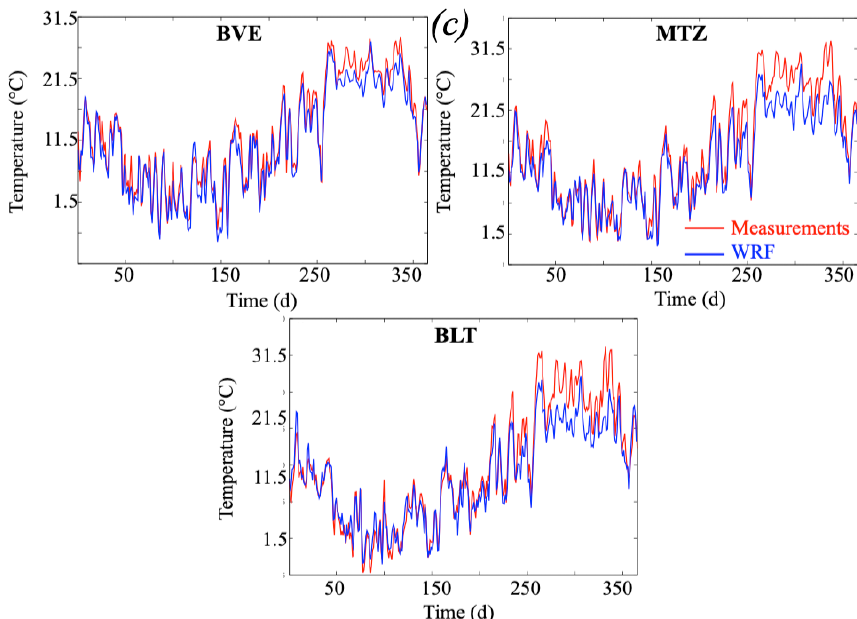
Figure A4. (a) Location of the four selected stations. These stations allow for comparing the simulated precipitation and temperature with measurements in the Sierra Nevada Mountains (BVE and MTZ), the volcanic intrusion (BLT), and the Central Valley (ELG). (b) Comparisons between simulated and measured precipitation at the four selected stations. The reasonable match between measurements and simulations at different locations allows for gaining confidence in the WRF simulations to reproduce the atmospheric dynamics at different elevations. (c) Comparisons between the simulated and measured temperature at three selected stations. The station ELG does not have measurements of temperature. Like the precipitations results, our comparisons indicate a reasonable match between measurements and